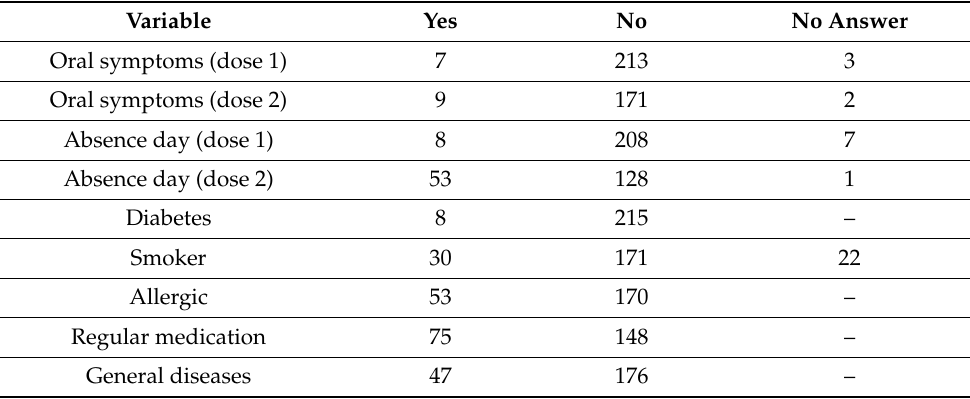
Table 3. Distribution of binary variables.